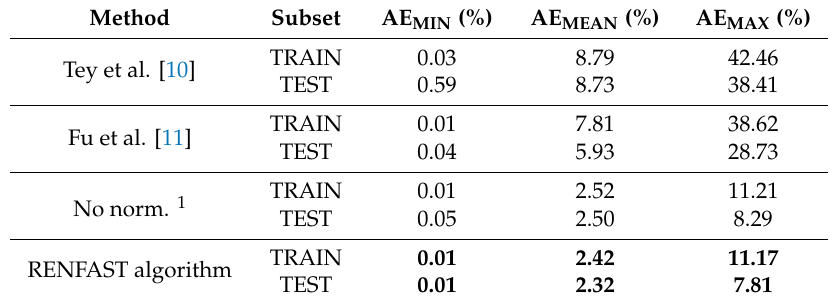
Table 5. Minimum, average, and maximum absolute errors (AE MIN , AE MEAN , AE MAX ) between manual and automatic fibrosis quantification.